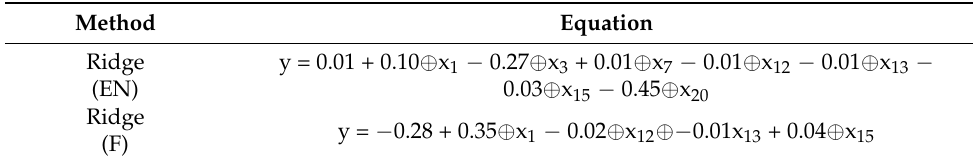
Table 4. Predictive errors for calculated